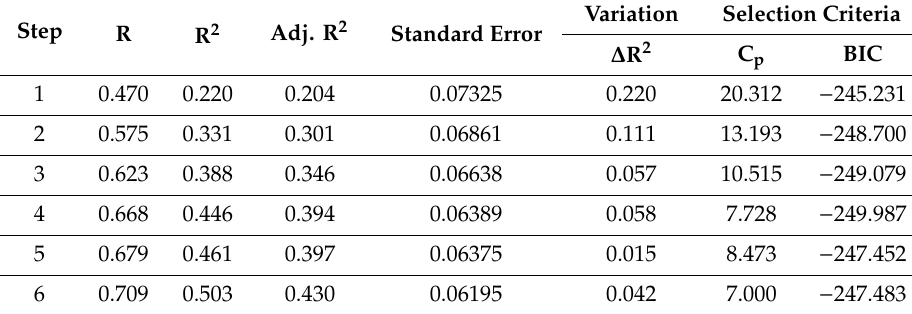
Table 4. Test regression model